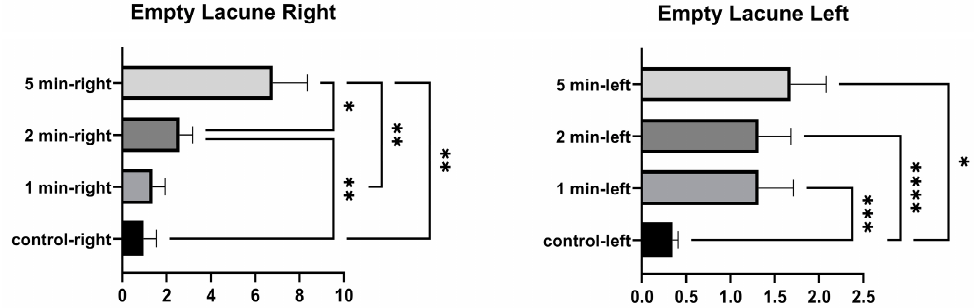
Figure 4. Empty lacunae graphs of the left and right tibia. ( p ≤ 0.05) as *, ( p ≤ 0.01) as **, ( p ≤ 0.001) as *** and ( p ≤ 0.0001) as